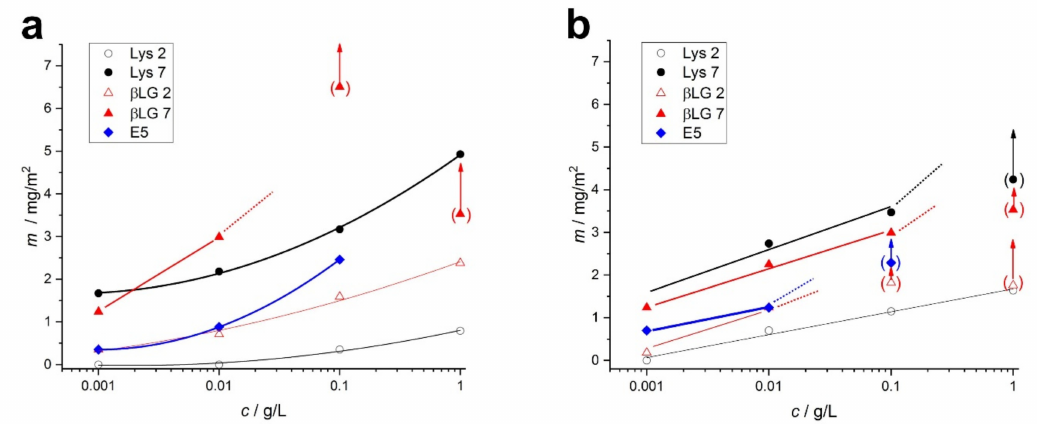
Figure 8. Adsorbed amount, m (mg/m 2 ), of each protein ( a ) and its amyloid form ( b ) on QCM crystal surface measured at pH 2 (unfilled symbol) and 7 (filled symbol) at various concentrations. The arrows with the bracketed data points indicate where the determined adsorbed amount is